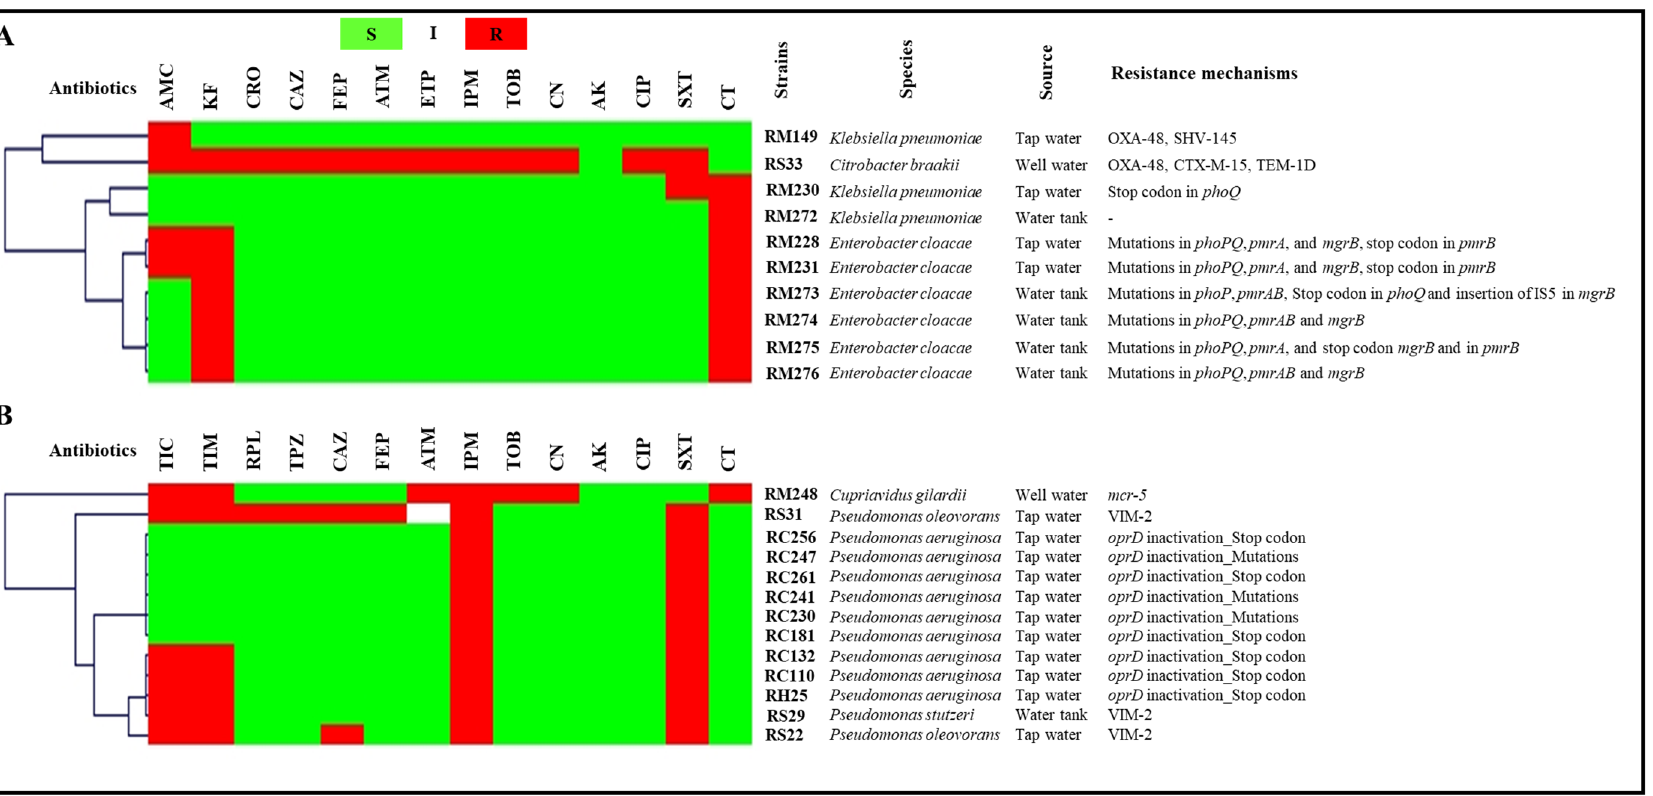
Figure 1. Antibiogram results and resistance mechanisms of tap water and well water isolates clustered using the MultiExperimentViewer (MEV) software version 4_6_2. ( A ), enterobacteria; ( B ), glucose-non-fermenting GNB. AK, amikacin; AMC, amoxicillin/ clavulanate; ATM, aztreonam; CAZ, ceftazidime; CIP, ciprofloxacin; CN, gentamicin; CTX, cefotaxime; CT, colistin; ETP, ertapenem; FEP, cefepime; I, intermediate; IPM, imipenem; KF, cefalotin; R, resistant; S, susceptible; SXT, cotrimoxazole; TOB, tobramycin; Strains’ codes: RC, cancer hospital; RH, university hospital; RM, maternity hospital; RS, public hospital.